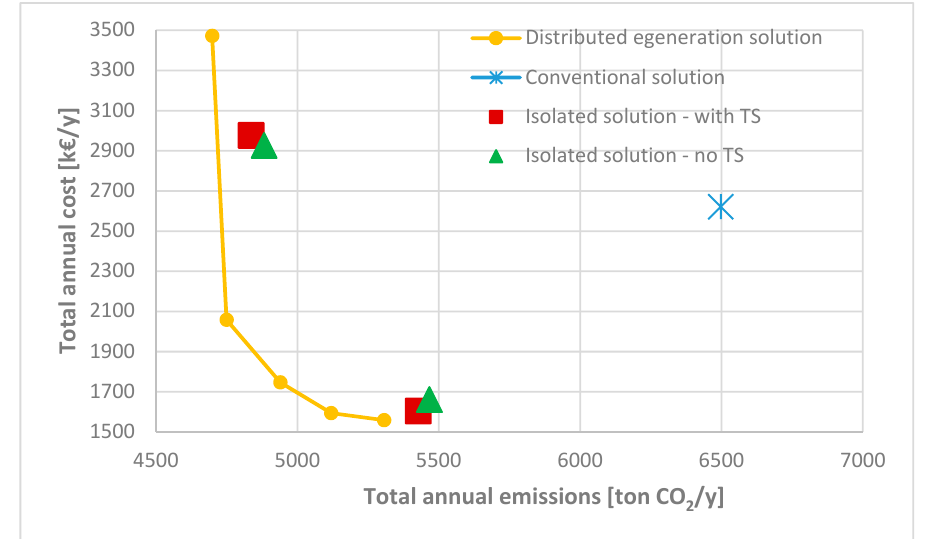
Figure 8. Pareto front of the optimal distributed generation solutions, including the points representing isolated solutions (with and without TS) and the conventional solution. Table 10. Total economic and environmental results of the optimizations—distributed generation solutions.